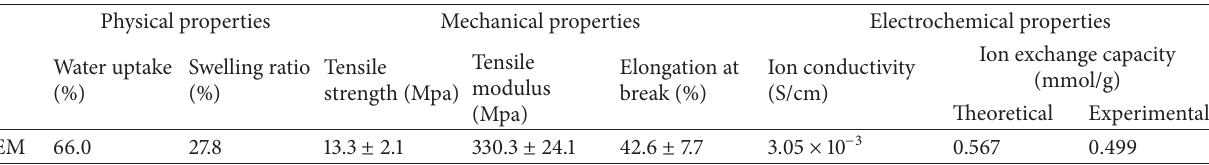
Table 1: Physical, mechanical, and electrochemical properties of the synthesized